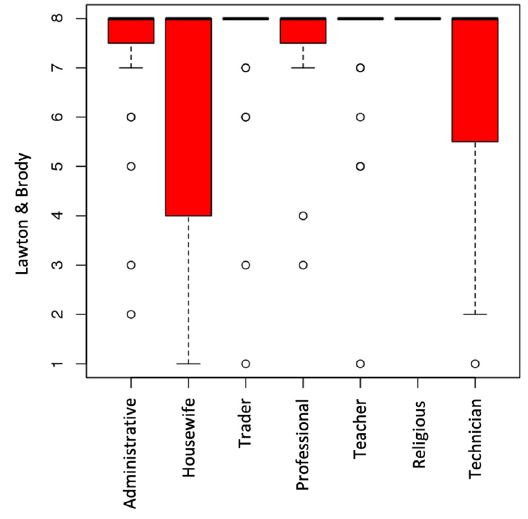
Figure 4. Relationship between Lawton and Brody and previous